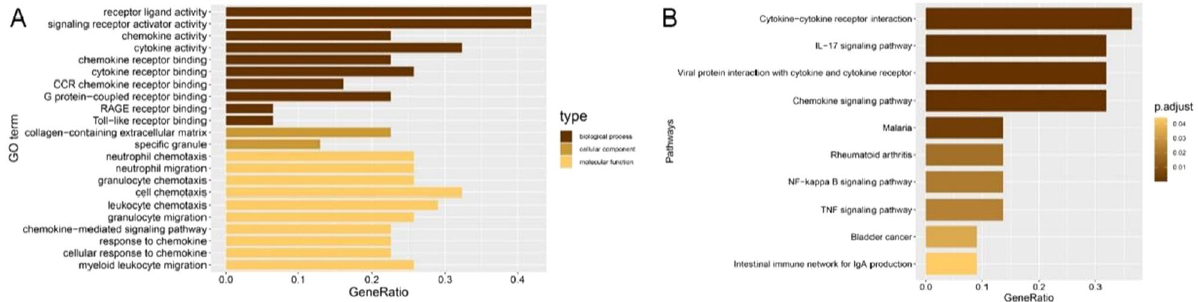
Figure 3. GO and KEGG pathway enrichment of IRGs. ( A ) GO enrichment; ( B ) KEGG pathway enrichment.